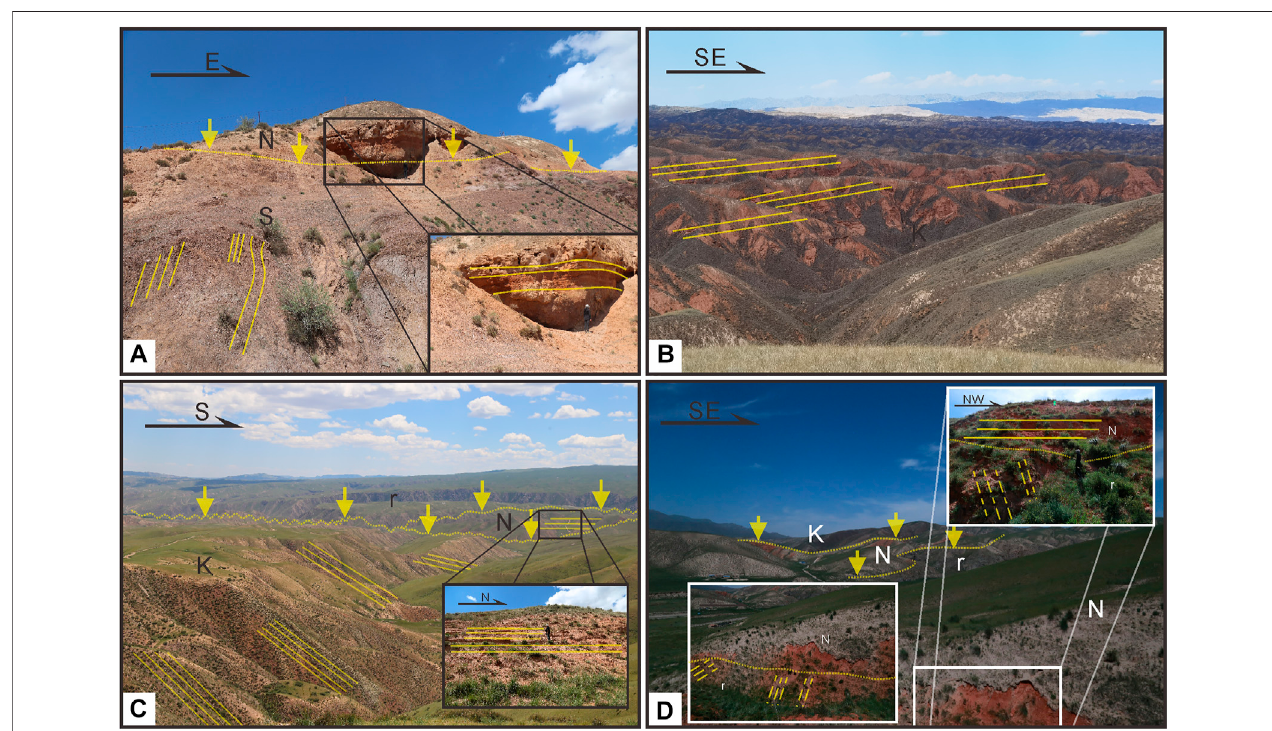
FIGURE 3 | Field photos of stratigraphic relationships in the study area. Yellow lines mean bedding. ( Figure 4 and Figure 5 for regional location of this map). (A) Strata of the Lamazui klippe. Neogene strata almost horizontally overlie Silurian strata. This shows the contact relationship between the SDL-3 and SDL-1. (B) Dipping Cretaceous strata that underwent little deformation in the central Sunan Basin. (C) Cretaceous strata in the Huangcheng Basin. From north to south, the dip angle changed from ~50 ° to ~20 ° . In the central basin, Neogene strata horizontally overlie Cretaceous strata and have an unconformable contact with the pluton. (D) PlutonintheHuangchengBasinoverlainbyredNeogenesandstones.TheNeogenestratacontacttheCretaceousstrataandplutonunconformablyintheeasternpartof the Huangcheng Basin. K: Cretaceous strata. N: Neogene strata. r: